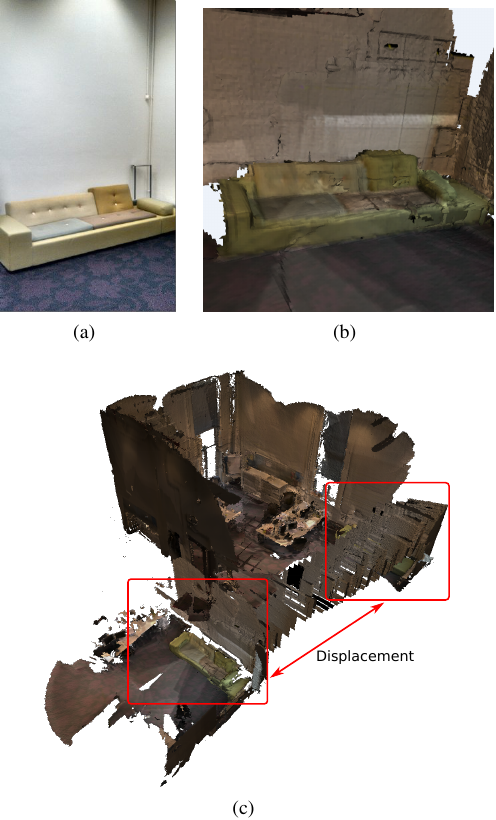
Figure 6: Motion tracking loss. (a) Couch with a wide featureless area above it. (b) 3D model of the couch. (c) Huge displacement of the scanned scene after focussing the tablet above the couch.